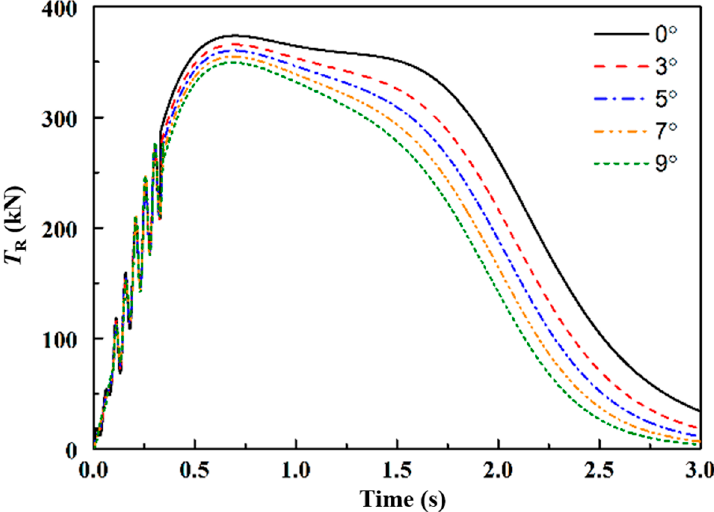
Figure 13. The starboard tape tension.